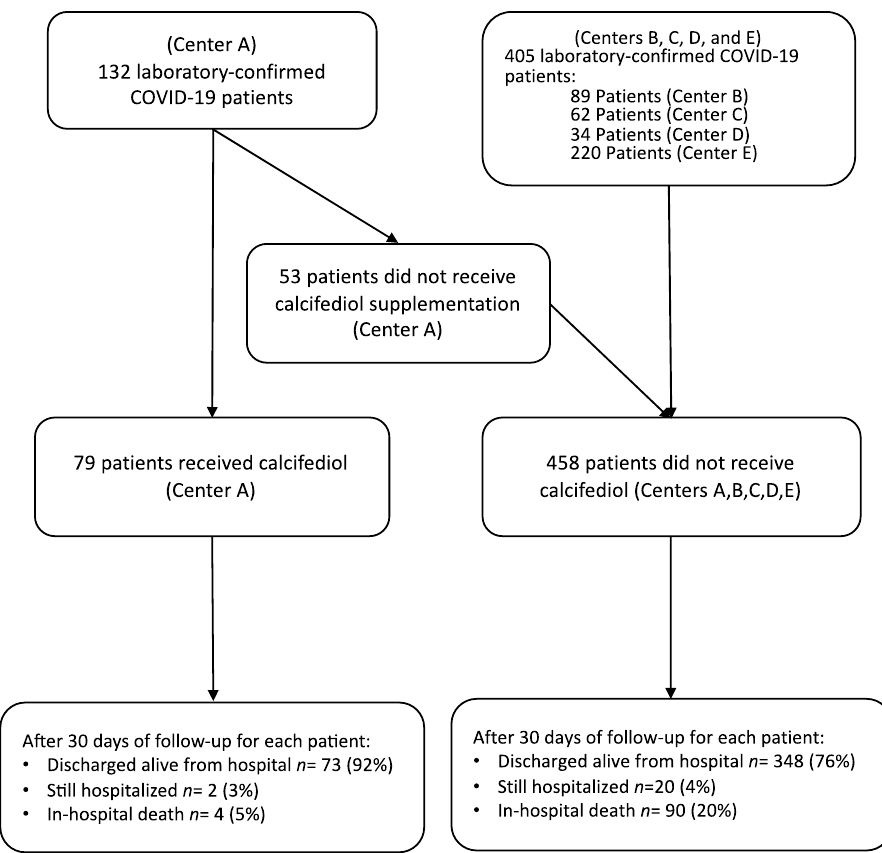
Figure 1. Flow chart of patients included in the study. Center A, Hospital Universitario Reina Sofia (Córdoba, Spain); Center B, Hospital Costa del Sol (Marbella, Spain); Center C, Hospital Alto Gualdalquivir (Andújar, Spain); Center D, Hospital Montilla (Córdoba, Spain); Center E, Hospital Universitario Regional (Málaga, Spain).